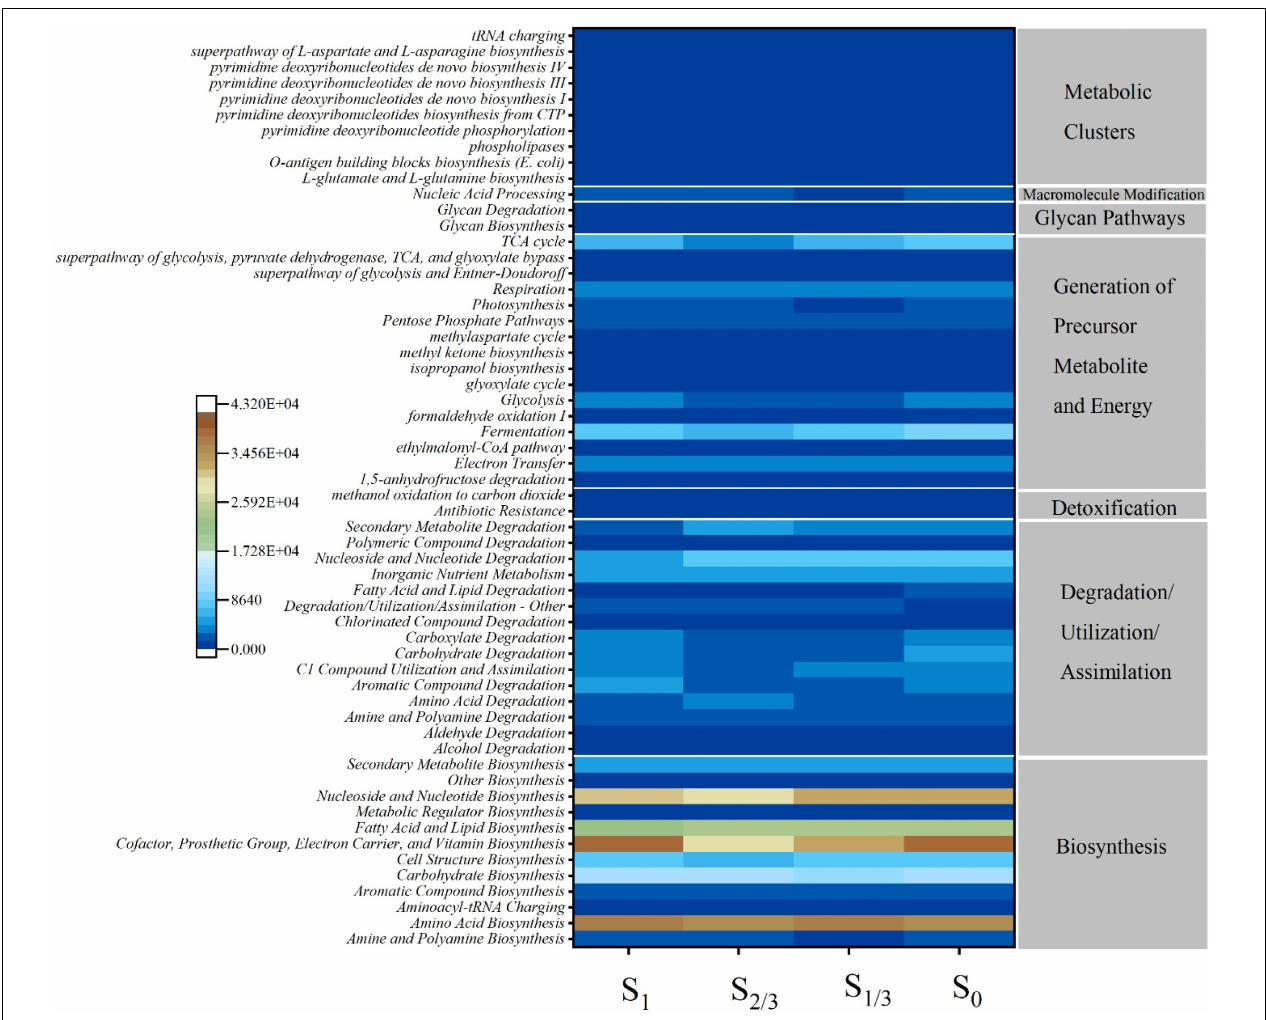
FIGURE 6 | Metabolic pathways of different functional categories predicted by PICRUSt algorithm based on the microbial composition of 16S rRNA. Legends represent the richness of the predicted readings, red for metabolic function with high richness and blue for metabolic function with low